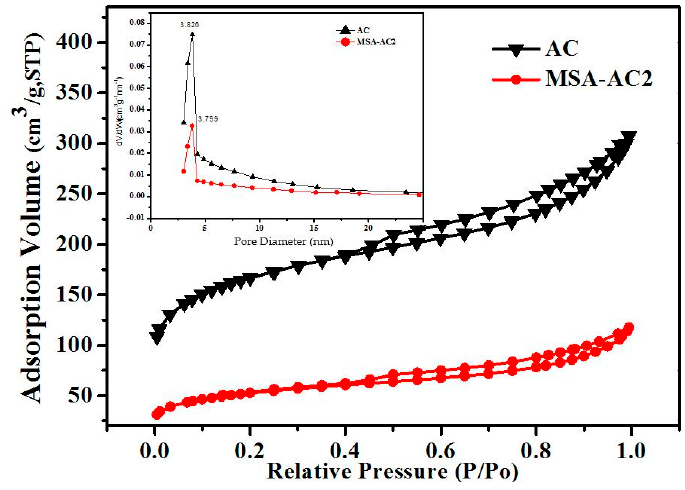
Figure 6. Nitrogen adsorption/desorption isotherms and pore size distribution curves of AC and MSA-AC2. Table 1. Porous properties of AC and MSA-AC.